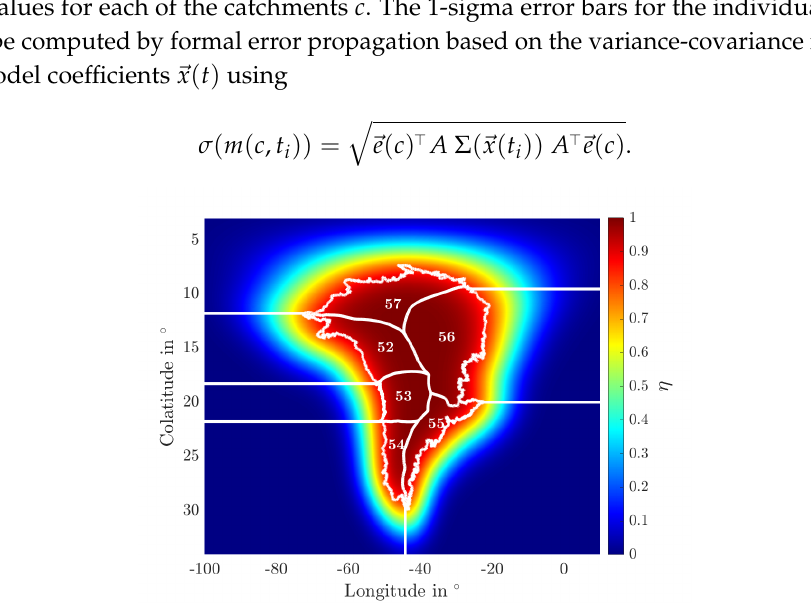
Figure 7. Weighting function η used to compute the relative masses of the six main glacier catchments in Greenland based on SH gravity field models. The boundaries of the catchments on land follow the ice divides [31] and are provided by the IMBIE project web site (http://imbie.org/imbie-2016/ drainage-basins/). The masses of the individual catchments are computed as weighted sum of the gridded mass points lying within the ocean and land areas assigned to the specific